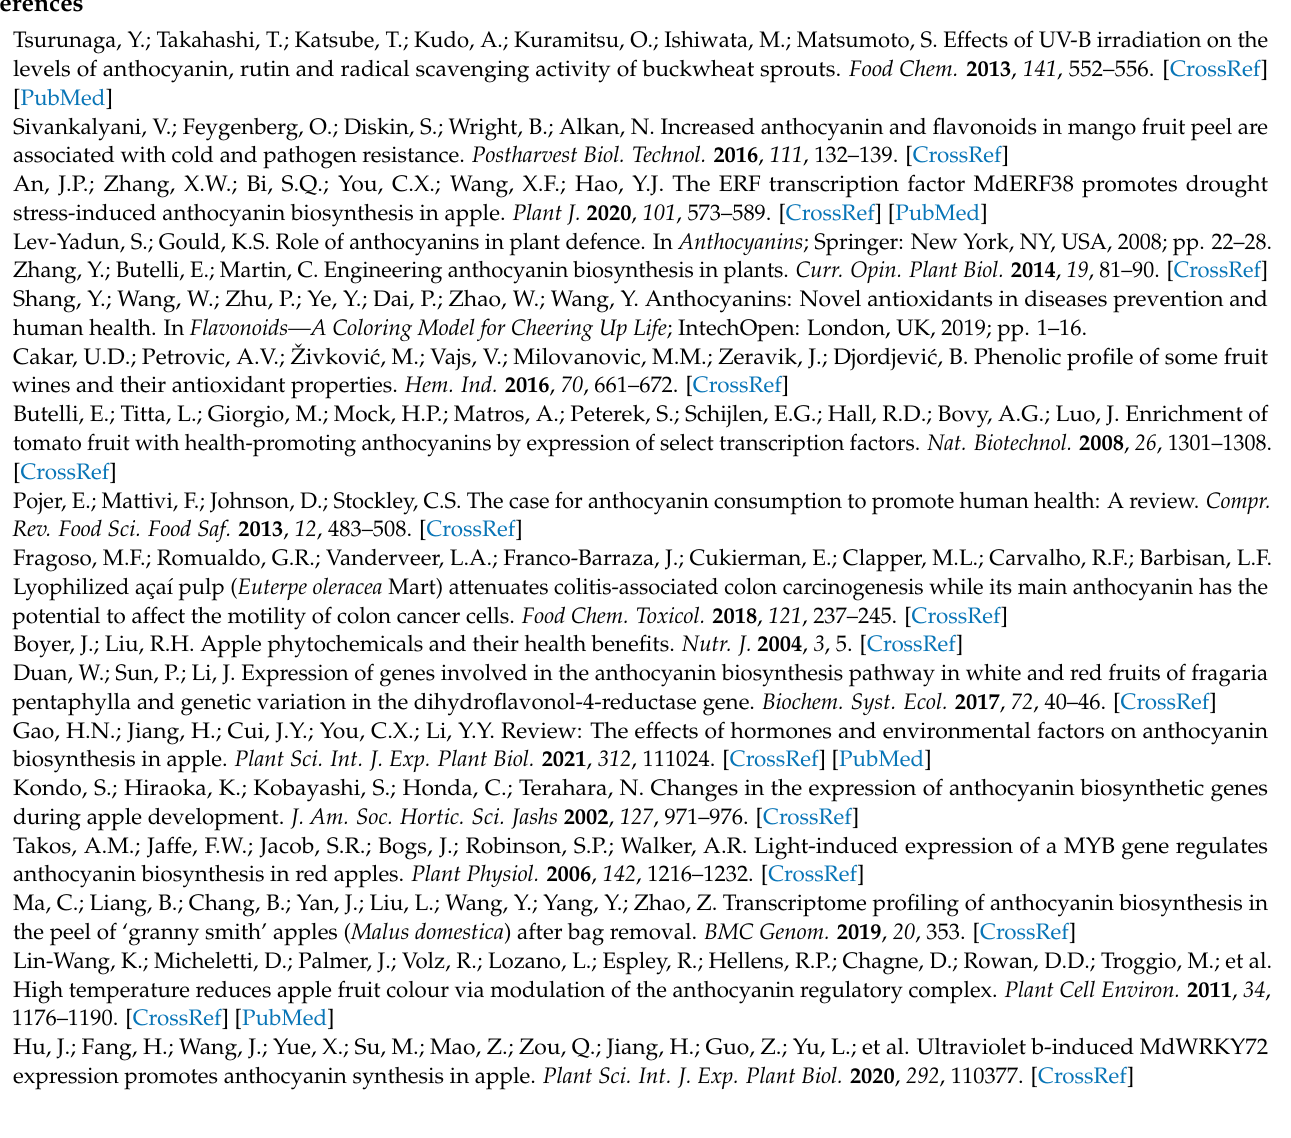
colors between nodes represent different relationships of proteins. Table S1: The primer sequences used in qRT-PCR. Table S2: Type and number of anthocyanins tested in this project. Table S3: Statistics of all sample quality control data. Table S4: Hormones related to anthocyanin accumulation. Table S5: Main transcription factor